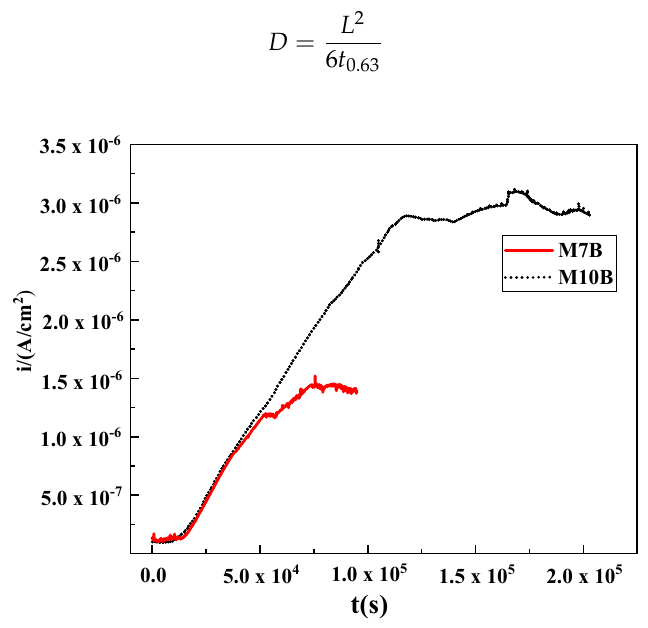
Figure 3. Hydrogen permeation curve of M7B and M10B.